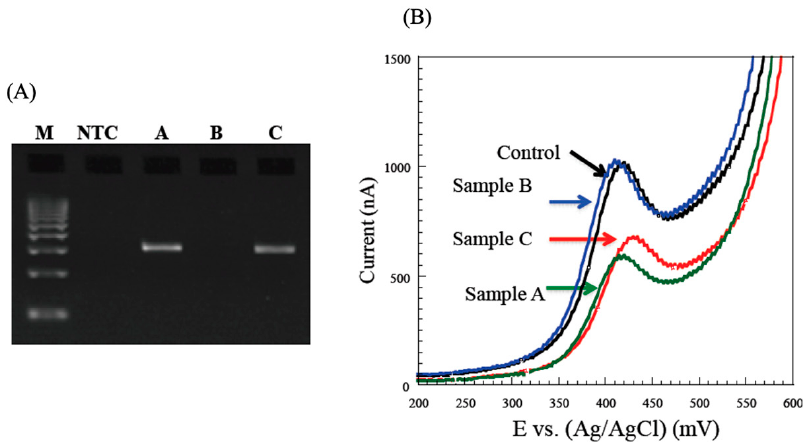
Figure 14. Detection of MRSA from patient samples [19]. ( A ) Electrophoresis of PCR-amplified genes encoding MRSA. Patient samples of A,C (positive) and B (negative) NTC: negative control; ( B ) Cyclic voltammograms (0–600 mV) were obtained with PCR amplified genes with patient sam- ples.